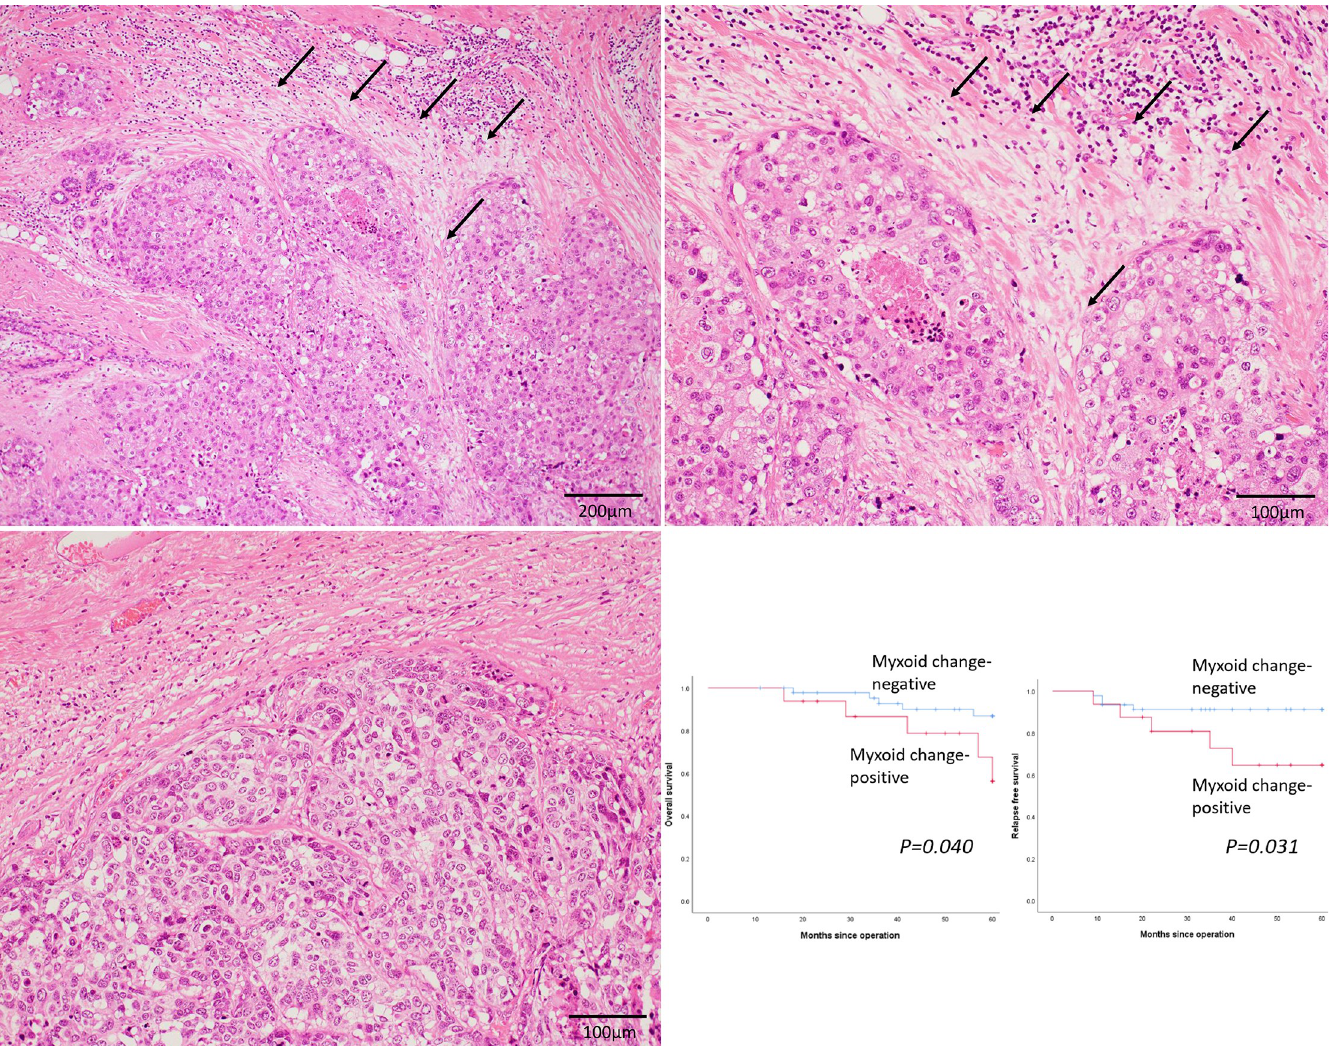
Fig 1. Myxoid change as an independent predictor of survival in patients with triple-negative breast cancer. (a) (b) Representative image of myxoid change in triple- negative breast cancer. Accumulation of amorphous stromal substances around the tumor nests (arrows) (x 100 (a) and x 200 (b)). (c) Only fibrous stroma is present, and no myxoid change is observed around the tumor nests (x 200). (d) Kaplan–Meier curves for the overall survival (OS) and relapse-free survival (RFS) of patients with triple-negative breast cancer. OS (left) and RFS (right) curves among myxoid change-positive (red line) and myxoid change-negative (blue line) patients.